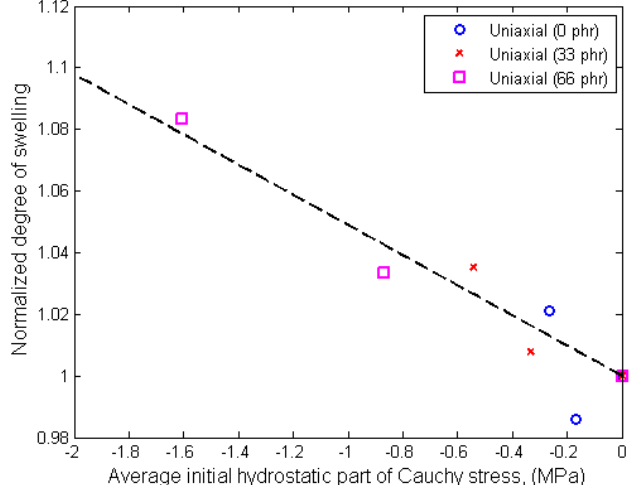
Figure 9. Normalized degree of swelling as a function of hydrostatic